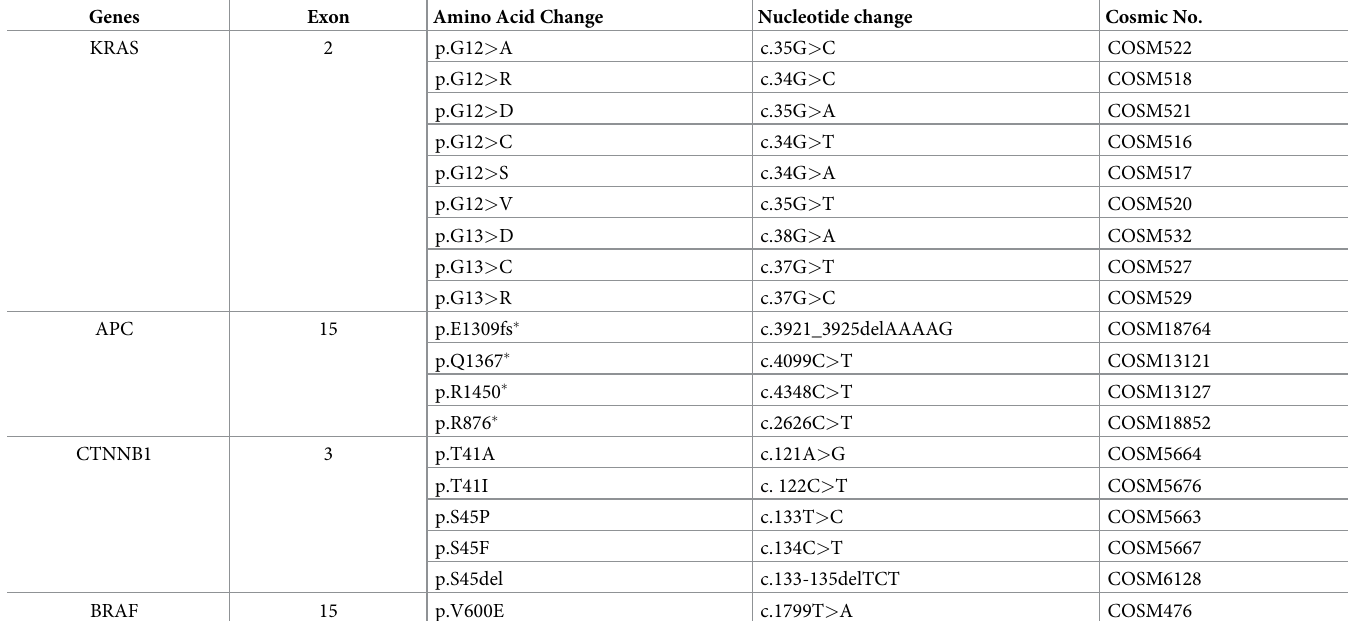
Table 1. List of Coloscape TM assay targeted gene